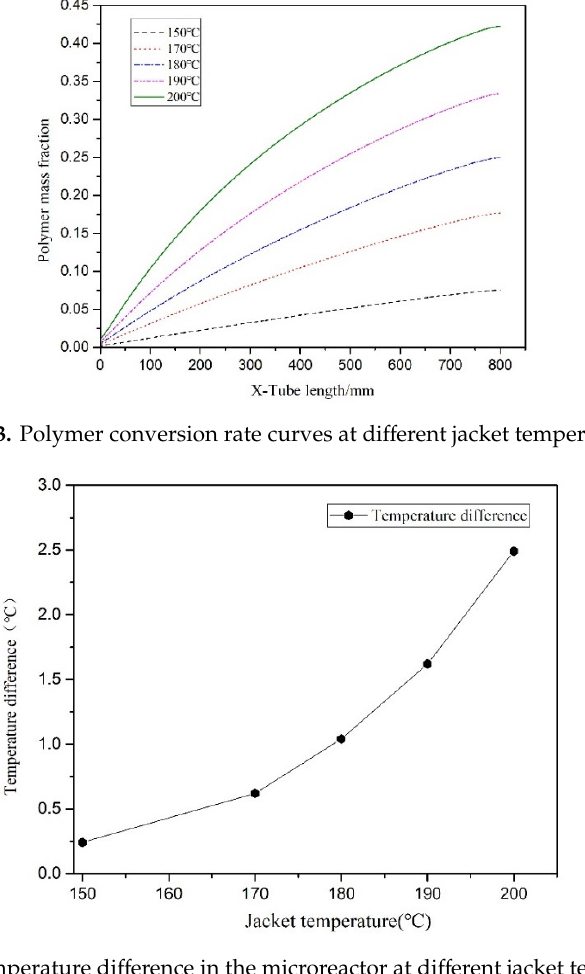
Figure 14. Temperature di ff erence in the microreactor at di ff erent jacket temperatures.